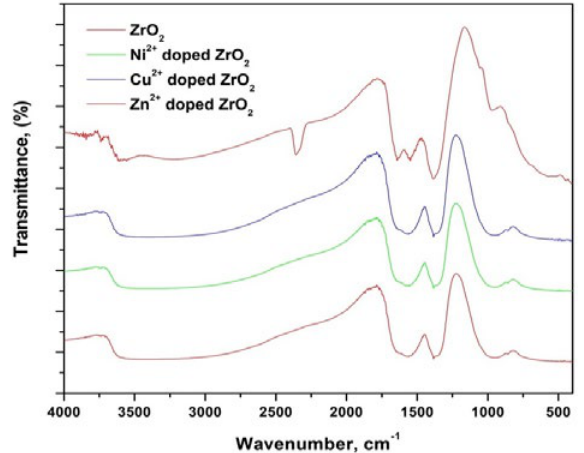
Fig. 3. FTIR spectra of the doped and undoped ZrO Fig. 3 FTIR spectra of the doped and undoped ZrO 2 NPs.